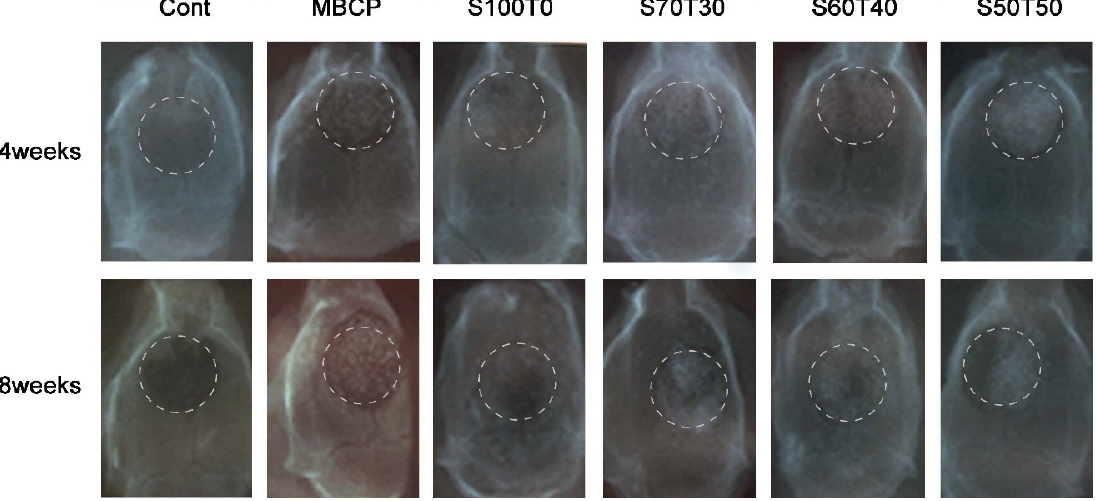
Figure 1. X ‐ ray pictures (four weeks and eight weeks); Cont is the blank control group. Figure 1. X-ray pictures (four weeks and eight weeks); Cont is the blank control